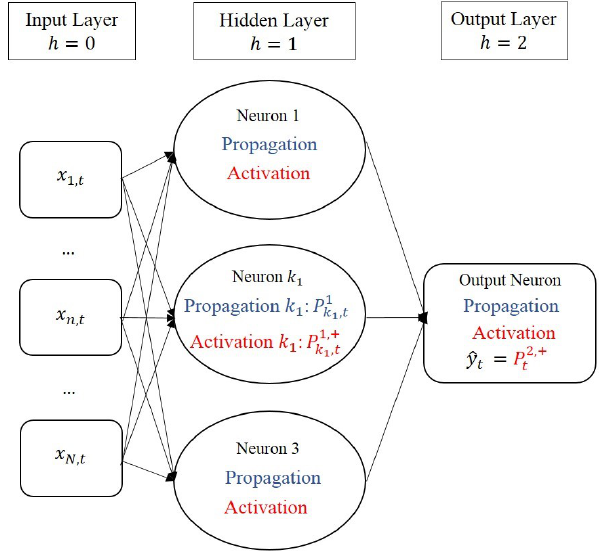
Figure 2. Feed-forward neural network with one hidden